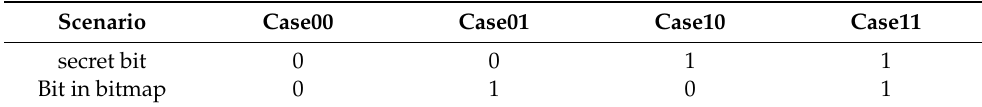
Table 1. Four scenarios for each pixel of a given block.